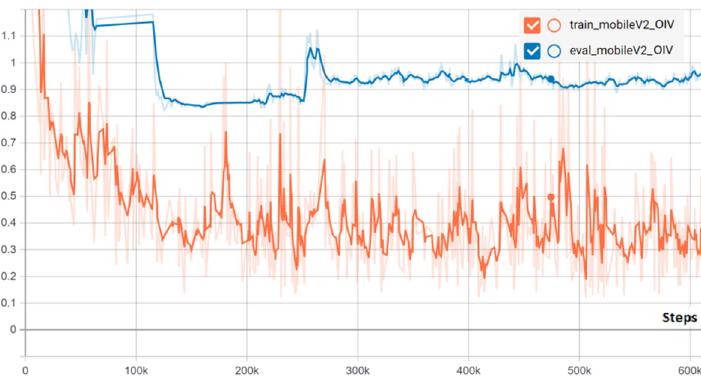
Figure 3. Recall of the trained models using Pascal VOC metrics.